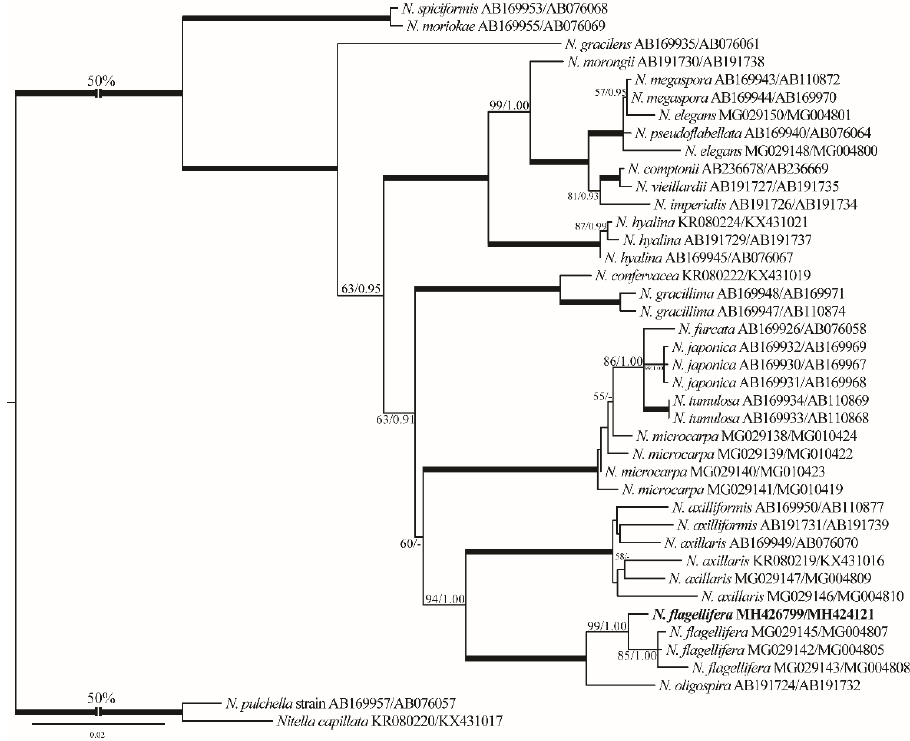
Figure 3. ML-phylogenetic tree inferred in PAUP with GTR+I+G nucleotide substitution model using 41 concatenated rbc L and ITS1 sequences of Nitella . See the legend of Figure 1 for details.